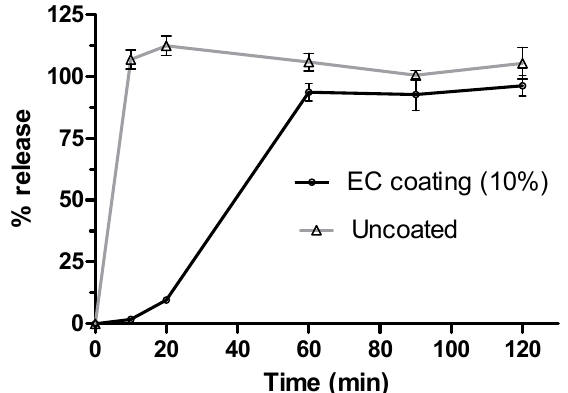
Figure 10. Dissolution study of gastro-protected CasHyd pellets. USP type 1 (basket) dissolution studies (50 rpm, 37.5 °C) showed gastro-protected release in simulated conditions (simulated gastric fluid sine pepsin, SGFsp; pH 1.2).